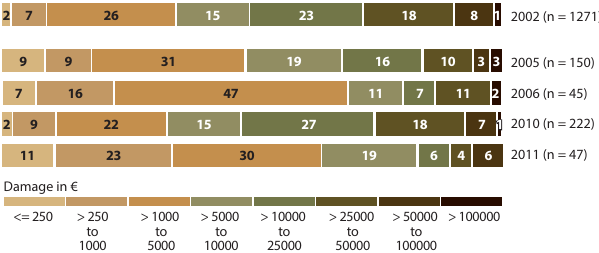
Figure 8. Classified damage to household contents (excluding mi- nor damage flat-rate), prices as of 2013.